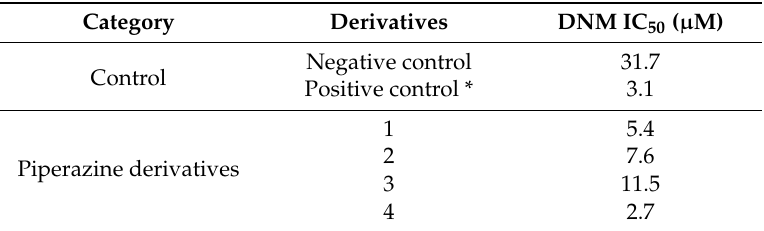
Table 1. The change in DNM IC 50 value by 100 µ M piperazine derivatives in vitro (The numerical data were represented the cell survival